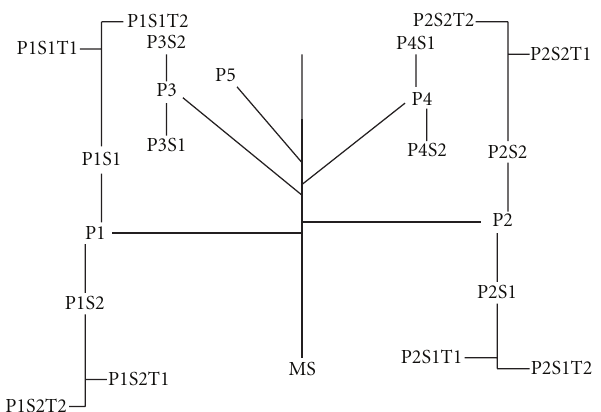
Figure 1: Tillering pattern of Oryza species. MS, P, S, and T, represent main shoot, primary, secondary, and tertiary tillers respectively. P1: first secondary tiller, P5: fifth primary tiller, P1S1: first primary tiller emerged on P1, P2S1: first secondary tiller of P2, P1S1T1: first tertiary tiller of P1S1, and so